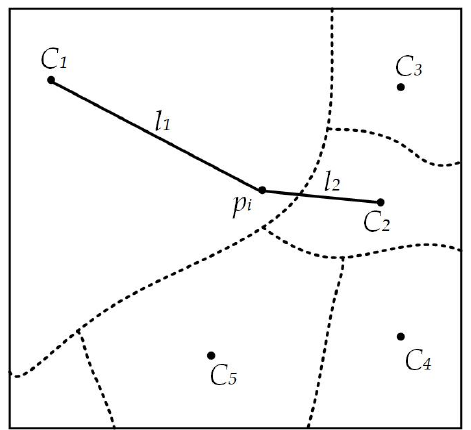
l between pixel p and seed point 1 i l from C . 2 2